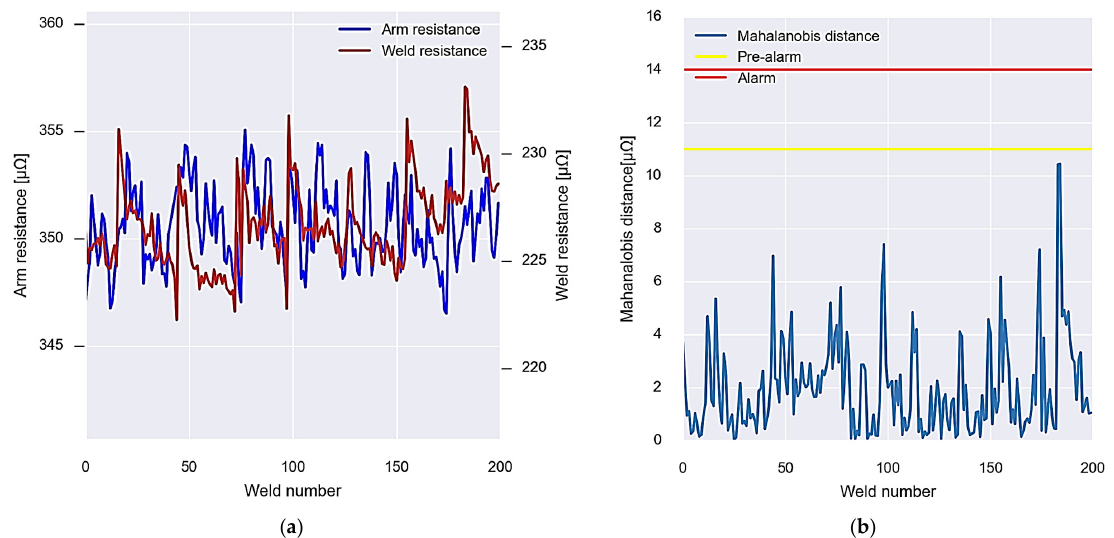
Figure 15. Operation of the first calibration algorithm for gun 2. ( a ) Data of the resistances used for the calibration. ( b ) Calibration result, Mahalanobis distance, and alarm thresholds.